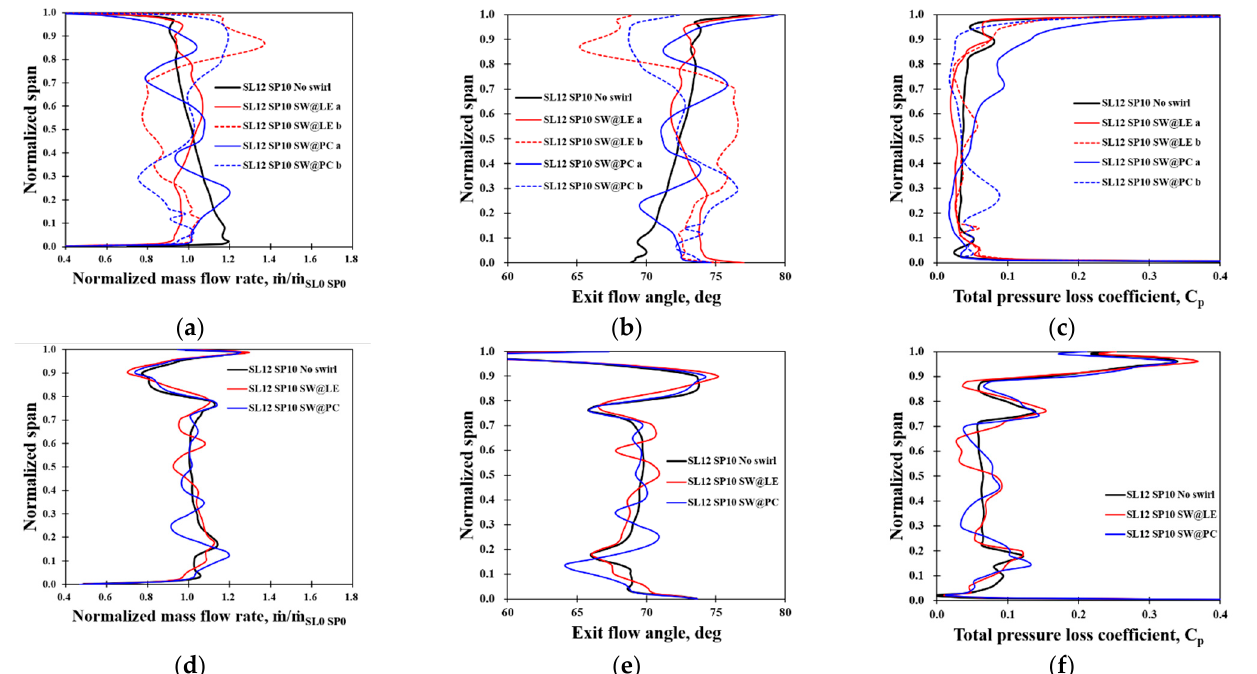
Figure 30. Comparison of circumferentially averaged mass flow rate ( a , d ), exit flow angle ( b , e ), and total pressure loss coefficient ( c , f ) of the SL12 SP10 model due to swirl clocking.